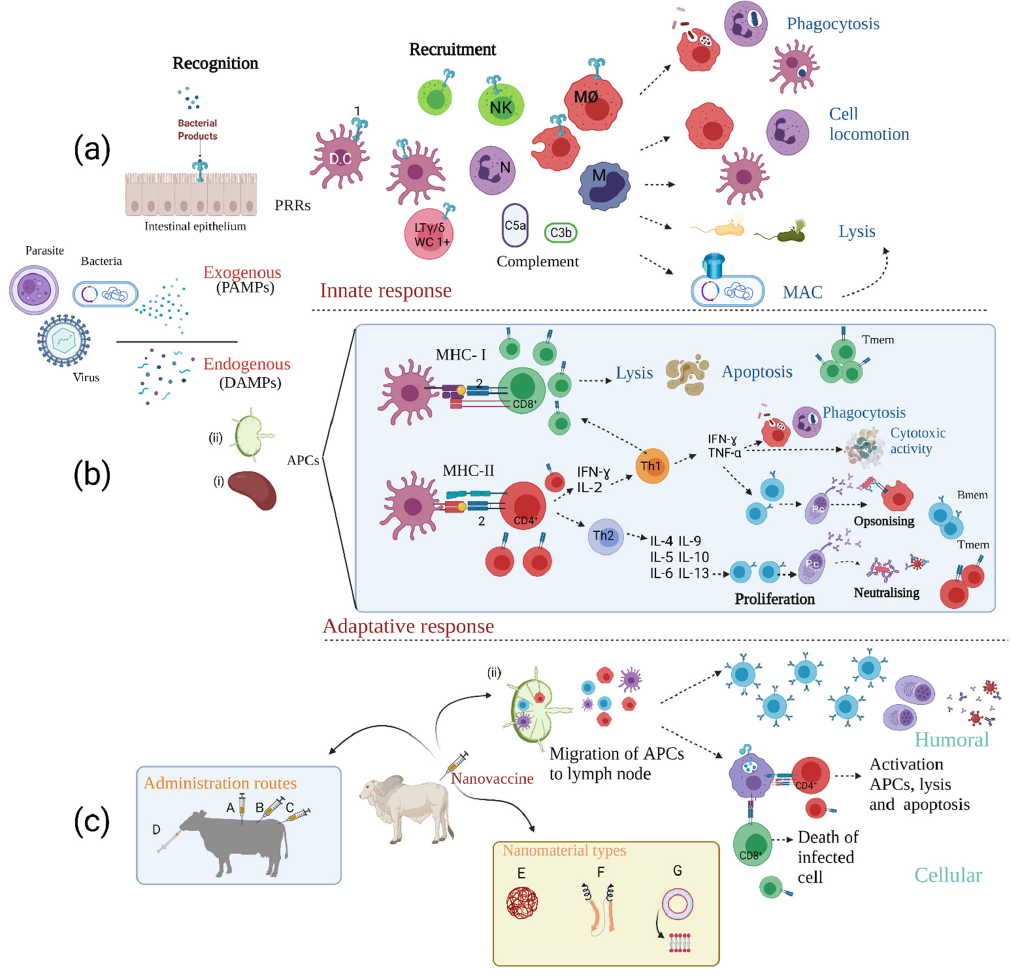
Figure 1. General representation of the immune response to pathogens and the effect of nanovaccines on the immune system. Recognition of exogenous pathogens (e.g., bacteria ( ), viruses ( ), and parasites ( is via their pathogen-associated molecular patterns (PAMPs). Endogenous particle recognition from dead or apoptotic cells is by damage-associated molecular patterns (DAMPs), thus activating the arms of the immune response: ( a ) innate